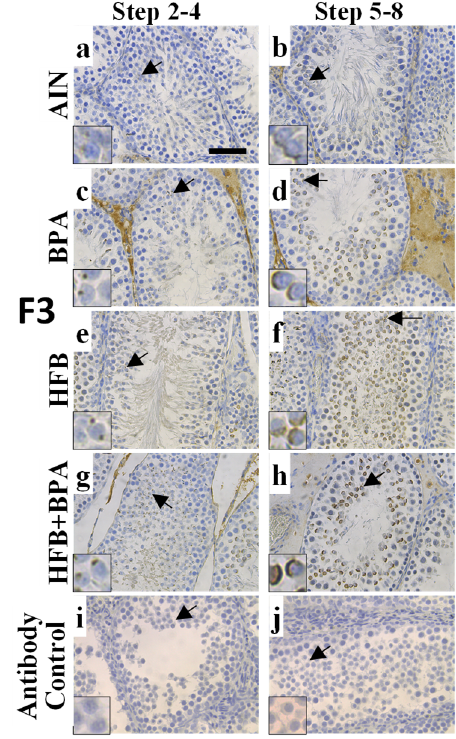
Figure 3. Cyp19A1 staining localizes to acrosomes in T + E2 − treated offspring. Representative tubules illustrating acrosomal staining within ( a , c , e , g , i ) spermatid steps 2–4 and ( b , d , f , h , j ) spermatid steps 5–8 using anti-Cyp19A1 antibody. ( i , j ) Negative control (no primary antibody). Bar = 60 µ m.